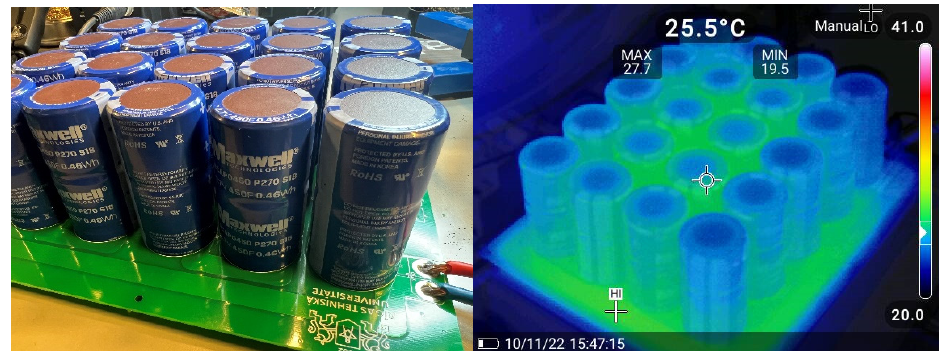
Table 1. Main parameters of the DC–DC converter.